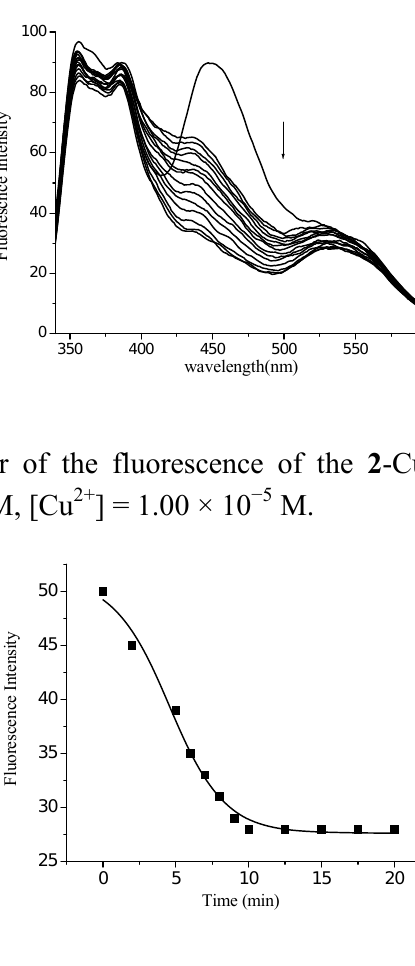
Figure 5. The Stern-Volmer plots of 2 -Cu 2+ system at